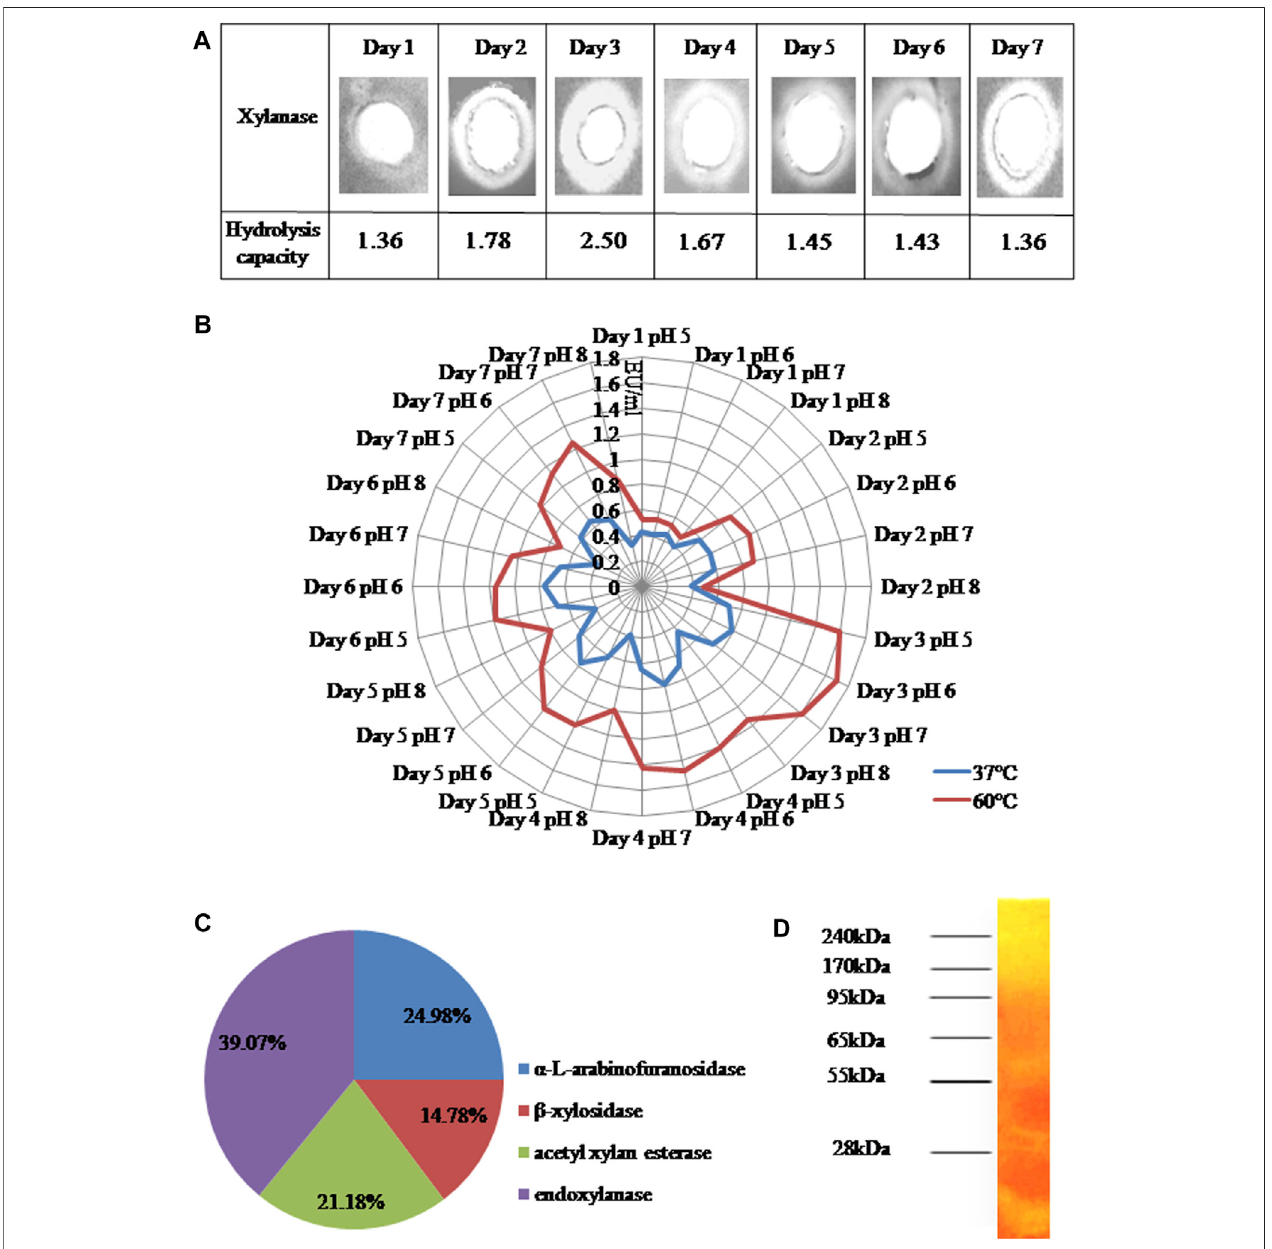
FIGURE1|(A) Detectionofxylandegradation asdeterminedonvariousdays ofgrowth ofRSCbyagarosewelldiffusionassay (B) Endoxylanase activities (EU/ml) at different temperatures (37 and 60 ° C) and pH (C) Relative abundance of xylanolytic enzymes (endoxylanases and accessory enzymes) in CFS of RSC after 3 days of growth at 60 ° C (D) Zymogram of extracellular xylanases present in XEP after 3 days of growth of RSC.